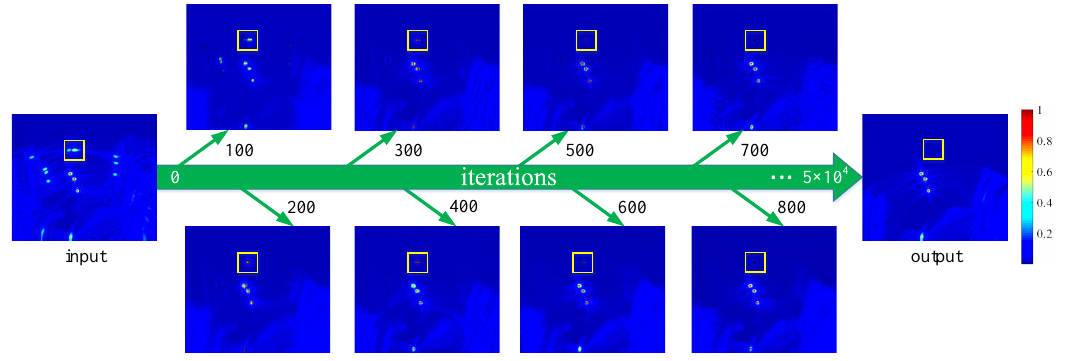
Figure 6. The output of GAN varies from the iterations of Dataset 1. The yellow rectangles indicate a part of the multipath ghosts’